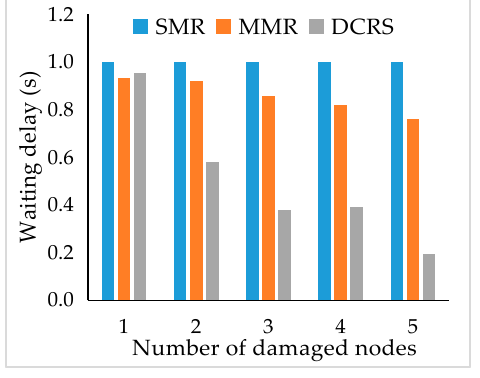
Figure 4. Degraded Read Latency. Figure 6. Degraded Read